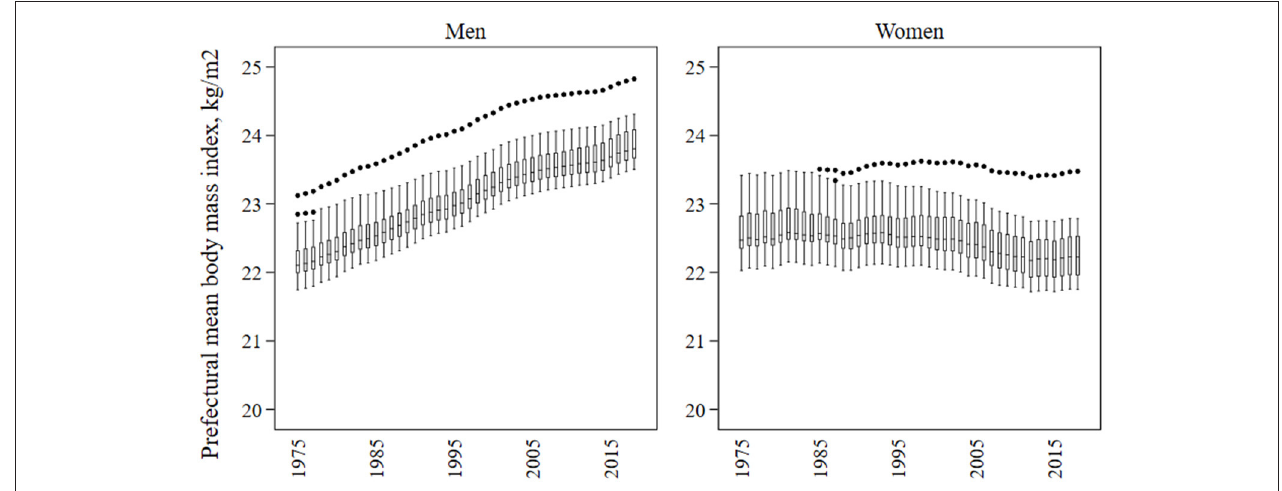
FIGURE 1 | Distribution of the age-standardized mean body mass index (kg/m 2 ) across the 47 prefectures of Japan in each year from 1975 to 2018. The box shows the 25th, 50th, and 75th percentiles. The lower adjacent line indicates minimum values or values less than the first quartile minus 1.5 times the interquartile range. The upper adjacent line indicates maximum values or values greater than the third quartile plus 1.5 times the interquartile range. Points show values below the lower adjacent value or above the upper adjacent